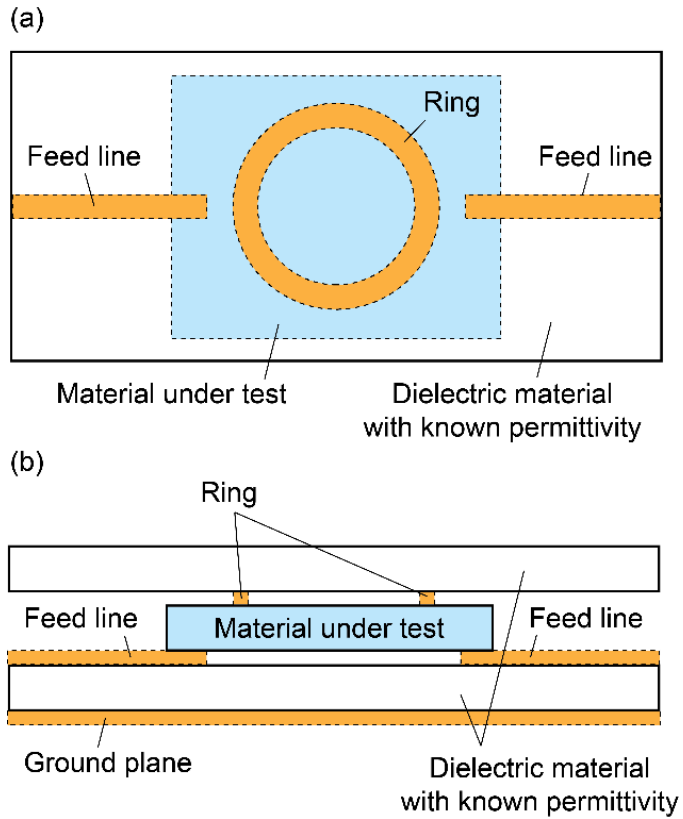
Figure 12. Schematic illustration of a suspended ring resonator for dielectric characterization: ( a ) top and ( b ) cross-sectional views. Redrawn from [94] (p. 21).